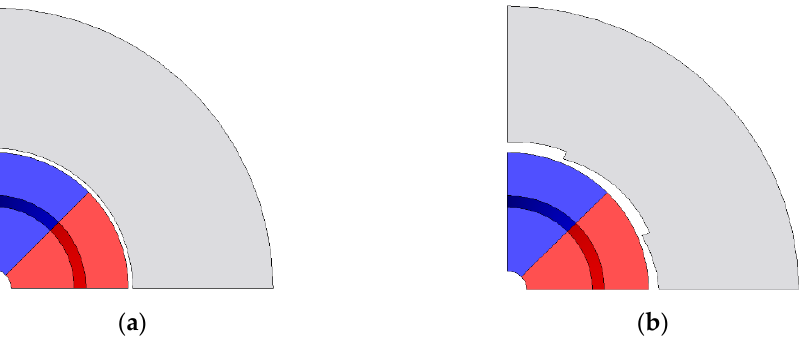
Figure 8. Topology comparison between the base and proposed model: ( a ) base model; ( b ) proposed model.